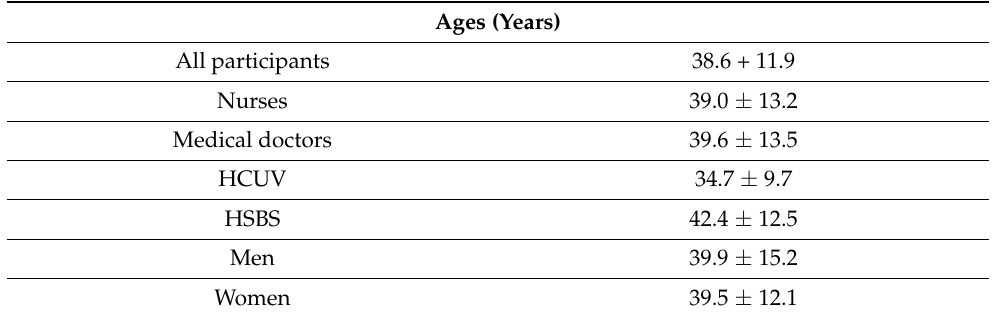
Table 2. Ages of